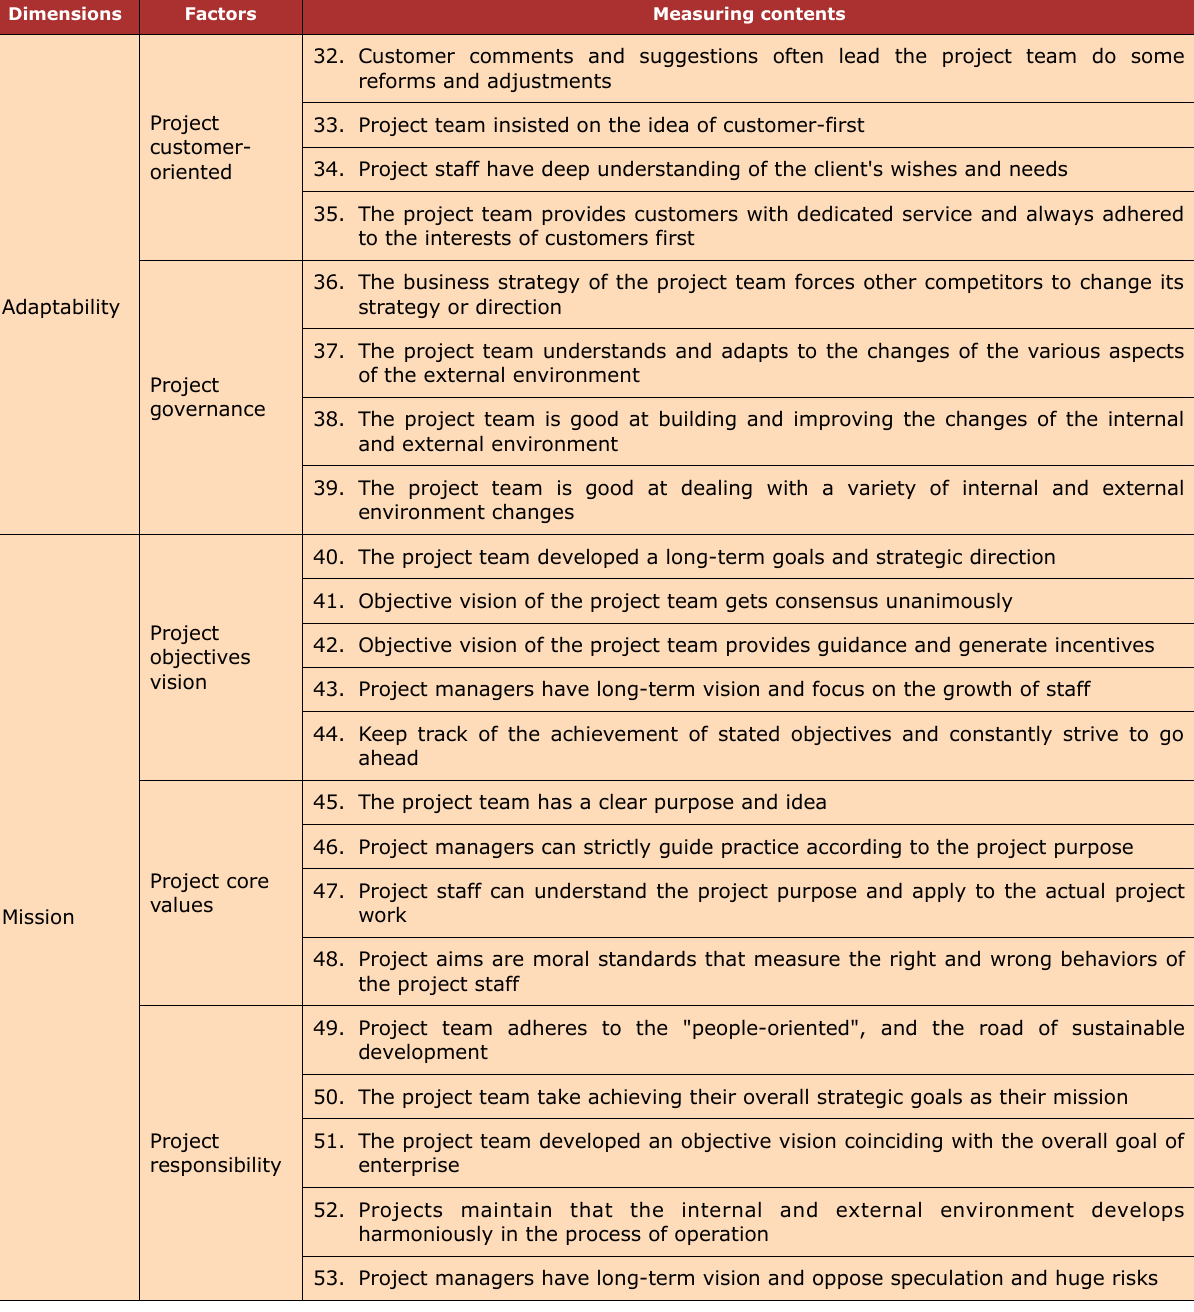
Table 1. Enterprise Cultural Assessment Scale